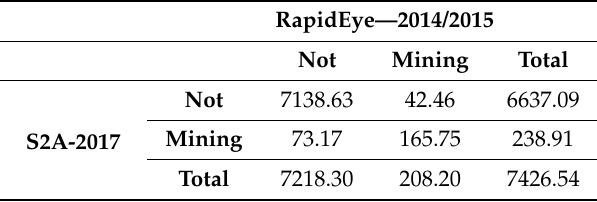
Figure 4. Evaluation of mining classification using S2A images having RapidEye classification maps (25 × 25 km) as ground truth. ( a ) Carajás region (Industrial), Kappa = 0.86; ( b ) Tapajós region (Small-scale), Kappa = 0.62; ( c ) Trombetas region (Industrial), Kappa = 0.87; and ( d ) Peixoto de Azevedo/Telez Pires region (Small-scale), Kappa = 0.59. RapidEye RGB (3, 5, 2) composition. S2A RGB (4, 8, 3) composition. Table 3. Confusion matrix of 12 RapidEye tiles and their Sentinel (S2A) equivalent area. Only two classes were considered, mining and not mining areas. Overall accuracy is above 98% and overall Kappa Index is 0.70.